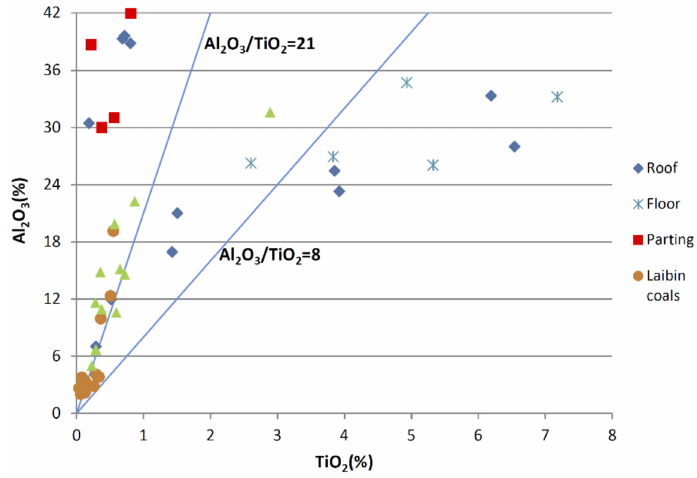
Figure 24. Plot of TiO 2 vs. Al 2 O 3 for coal plies, partings, roof, and floor samples from the Bole and Laibin Mines.